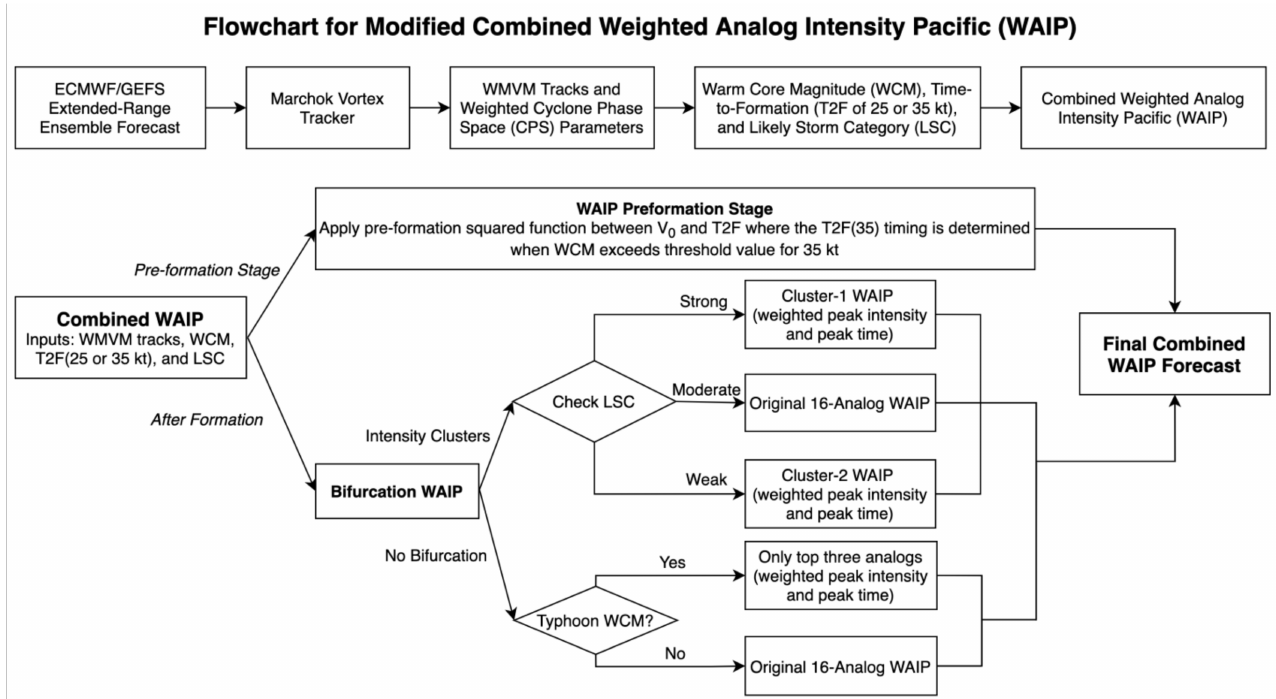
Figure 3. Flowchart summarizing in the first row the preparatory steps necessary to generate from the ECEPS forecast the inputs to the combined WAIP intensity forecasts. The larger lower flowchart summarizes the modified combined WAIP intensity forecasts in this study. No modifications are made for the WAIP pre-formation stage. The WAIP after-formation stage intensity forecasts are modified utilizing the bifurcation WAIP intensity Cluster-1 (Cluster-2) when there is a strong (weak) indication from the Likely Storm Category (LSC) that only those analogs with (without) a rapid intensification (RI) should be selected for the WAIP. Even if there is no bifurcation, an indication from the LSC of a likely typhoon will limit the analog selection to RI-type analogs and will stipulate that a weighted peak intensity and peak time will be applied (see